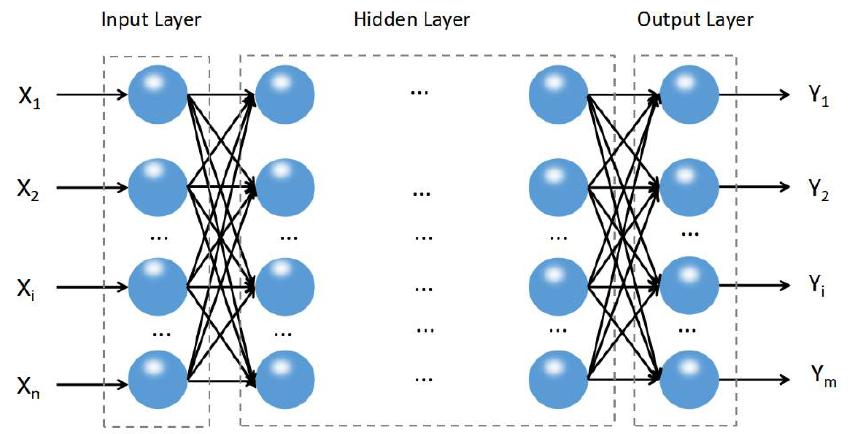
Figure 2. Structure of BP neural networks.